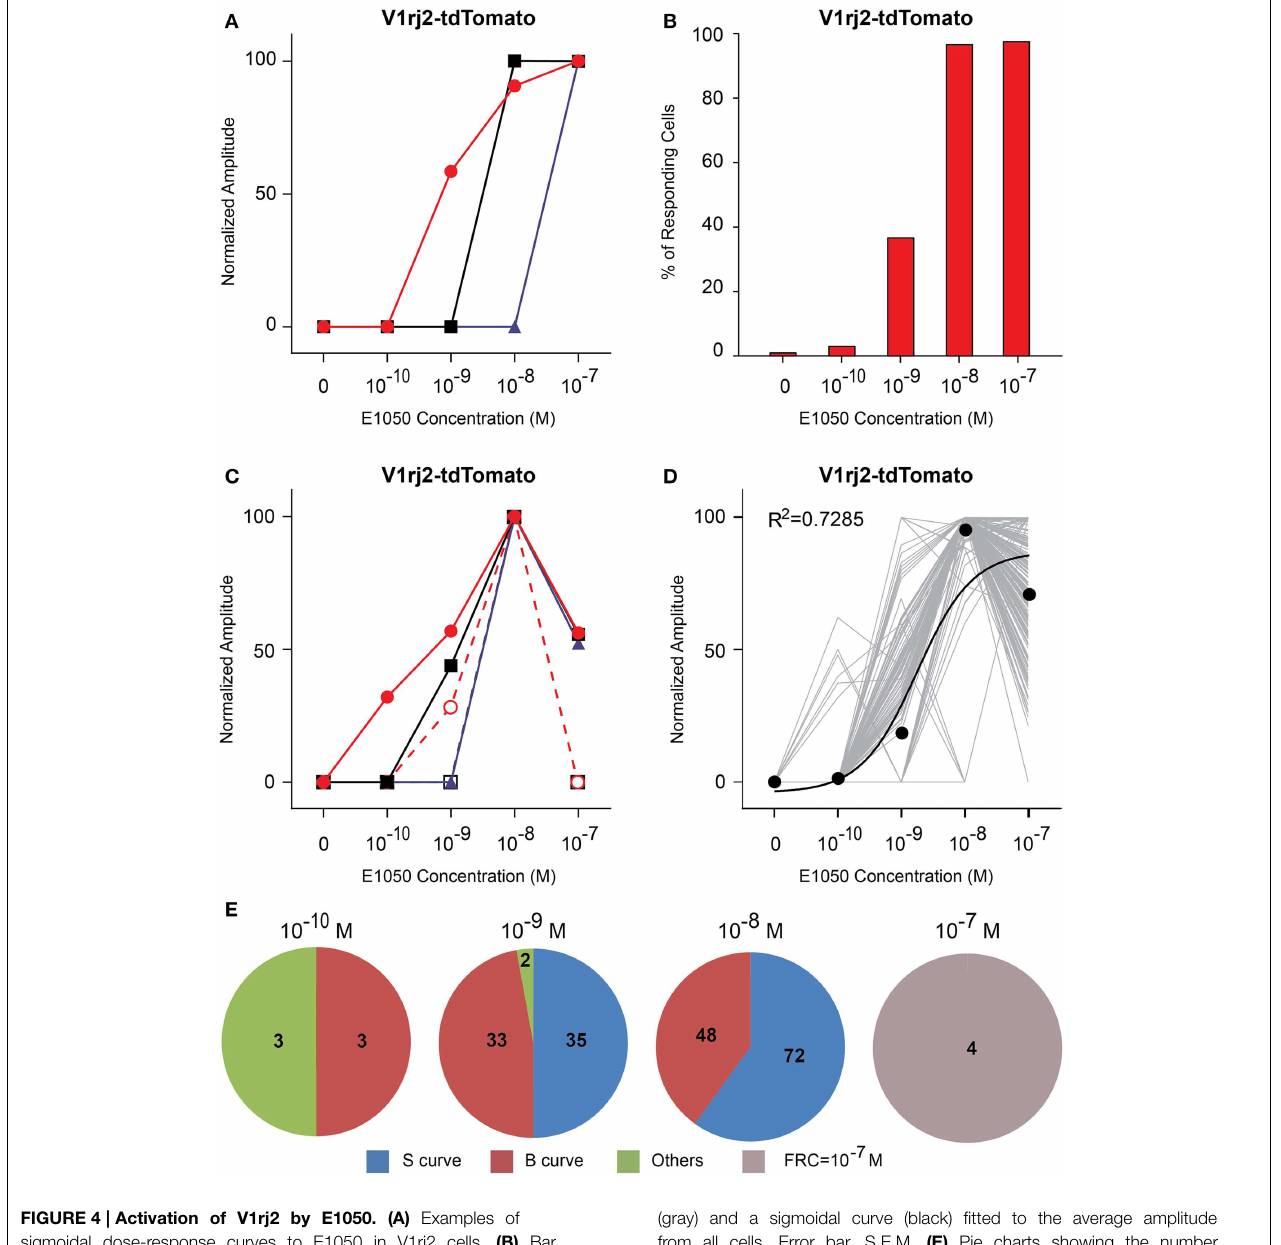
FIGURE 4 | Activation of V1rj2 by E1050. (A) Examples of sigmoidal dose-response curves to E1050 in V1rj2 cells. (B) Bar graph showing the percentage of E1050 activated V1rj2 cells ( n = 200 ). (C) Examples of bell-shaped dose- response curves to E1050 in V1rj2 cells. (D) Dose-response curves of individual cells